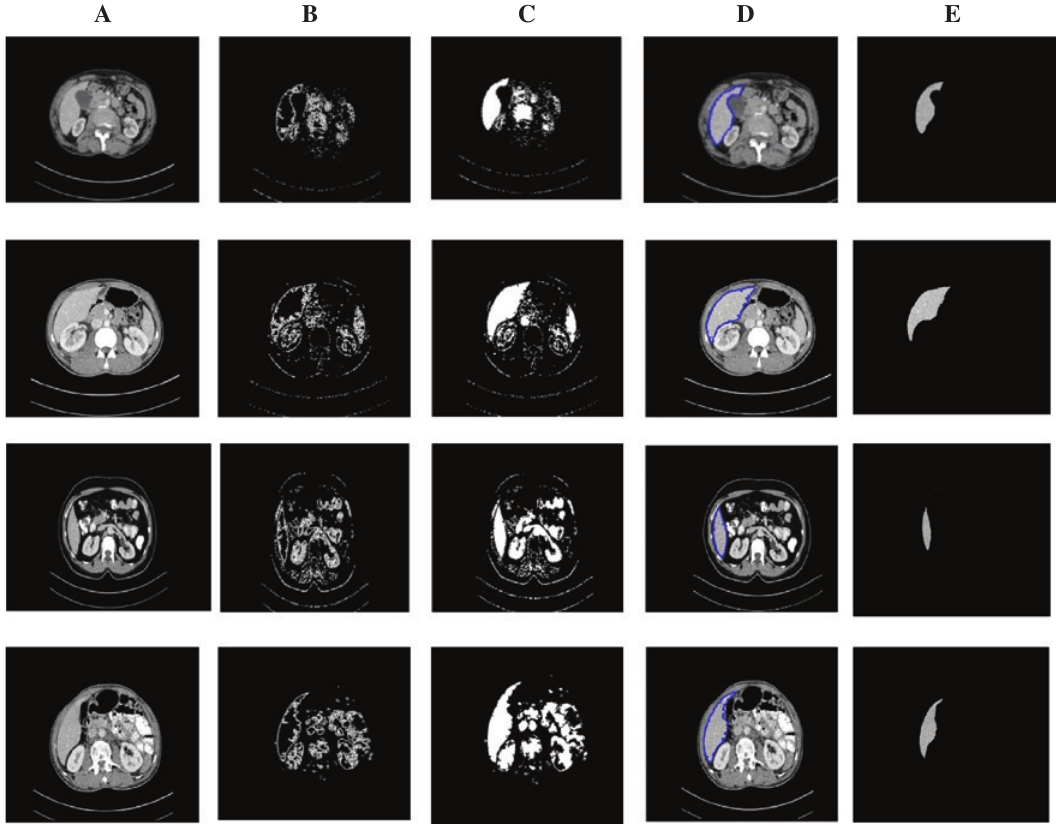
Figure 4: Experimental Results of the Proposed Method and Existing Models. Columns (A) input image (CT scan image), (B) edge image of the CT scan, (C) speed function of the liver image, (D) liver with boundary, and (E) ground truth